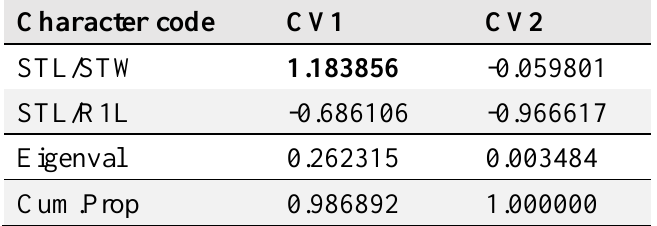
Table 4. Standardized canonical discriminant function coefficients for Aphidius